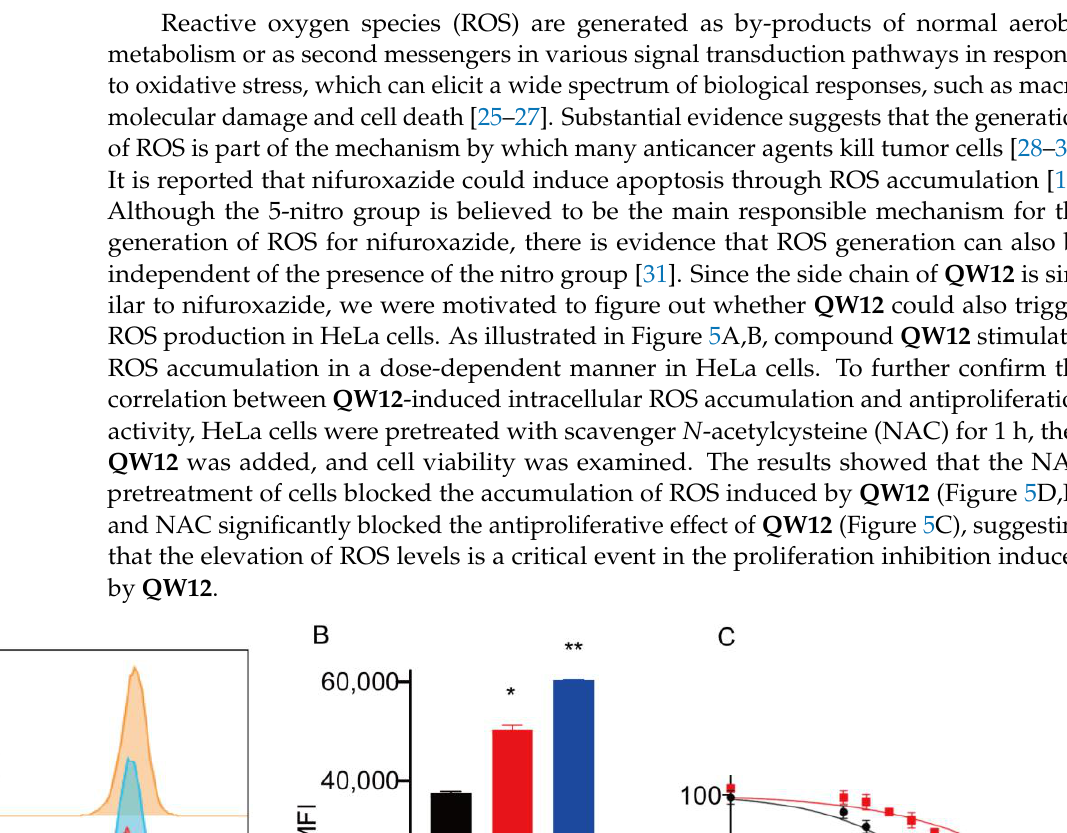
Figure 4. QW12 inhibited the proliferation of HeLa cells. ( A ) The plate-cloning experiment was used to detect changes in cell proliferation after the treatment of cells with QW12 . ( B ) Quantitative analysis of proliferation changes. Values are presented in means ± SD of three independent experiments.